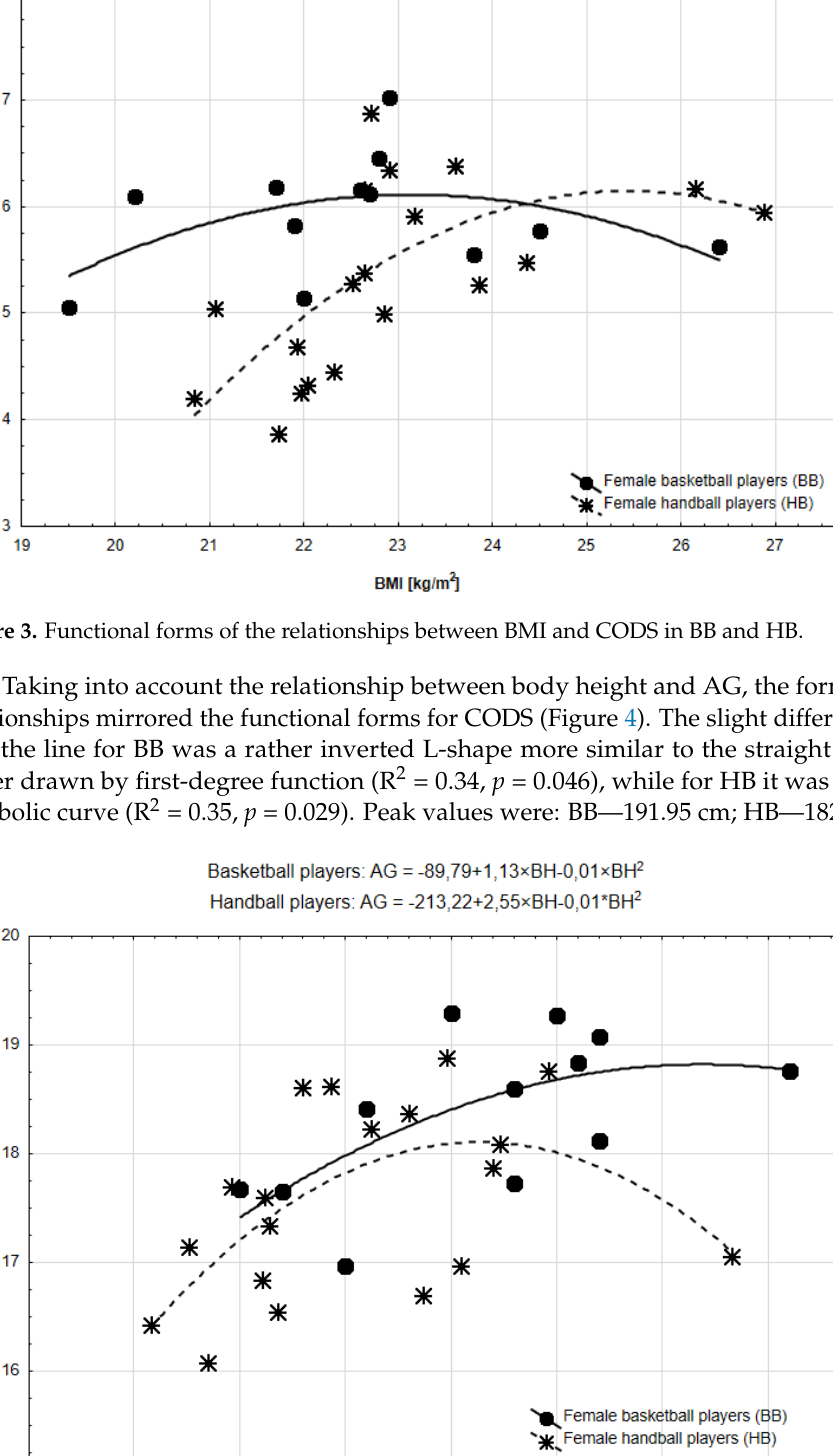
Figure 2. Functional forms of the relationships between body height (BH) and change of direction speed (CODS) in BB and HB.